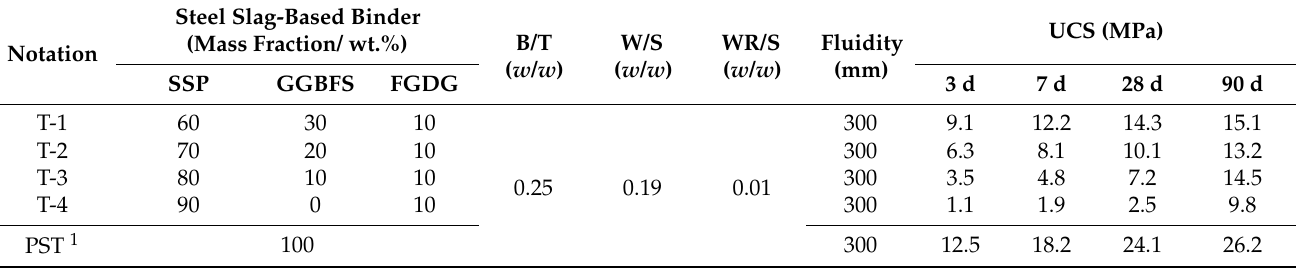
Table 2. Formulations for SSB, SST, and